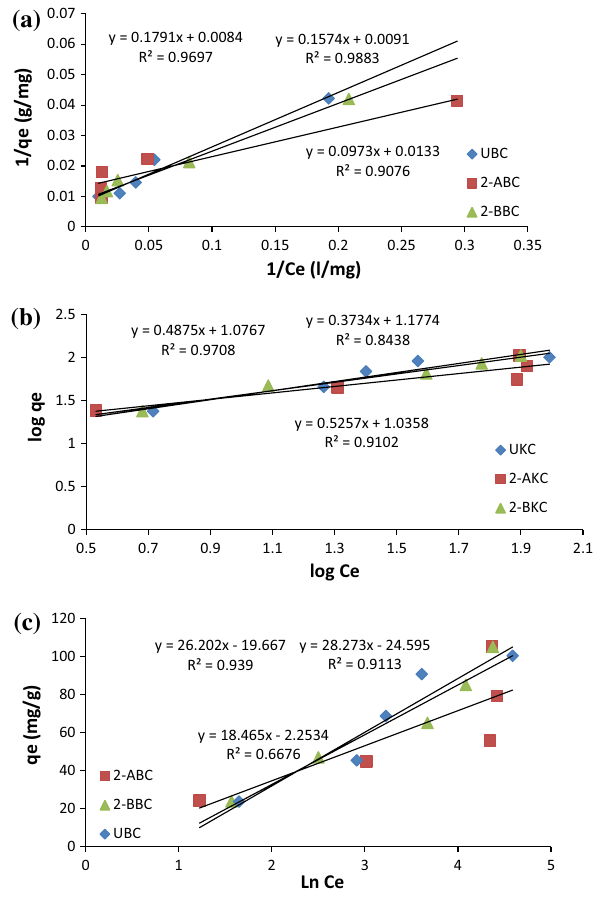
Fig. 6 Various adsorption isotherms for the removal of atrazine using